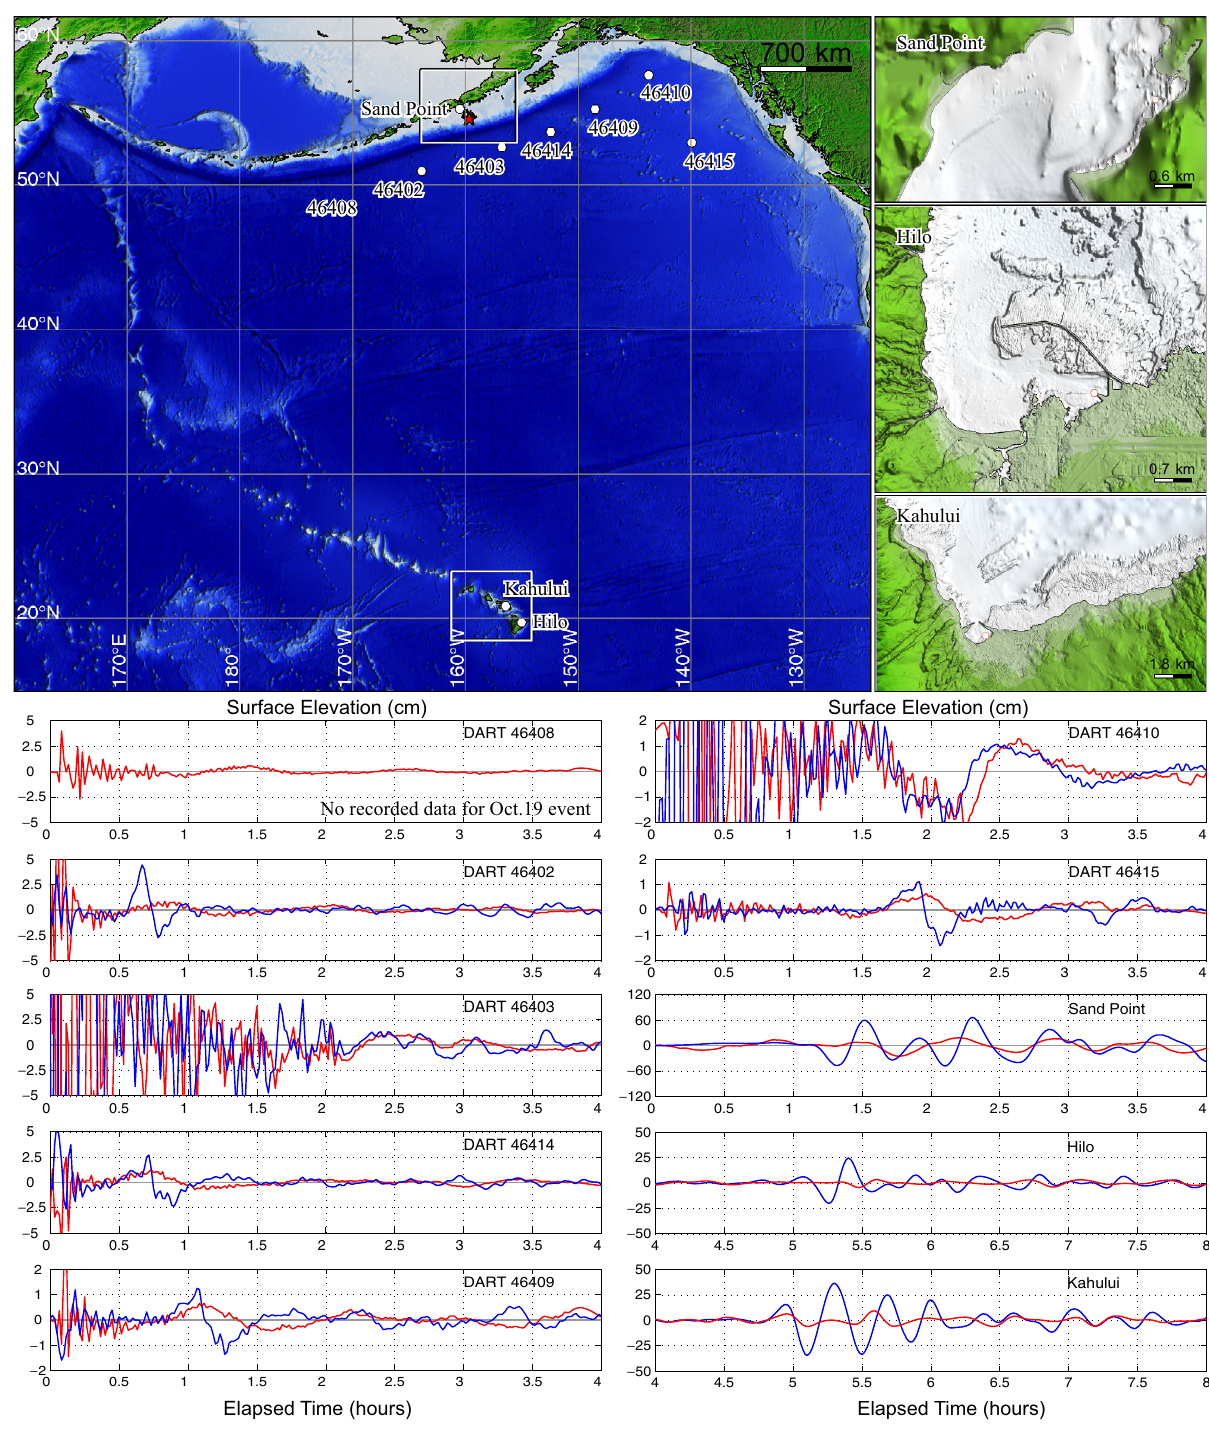
Fig.2|TsunamiobservationsfortheShumaginSegmentearthquakes. Topleft: mapofnorthPaci fi cbathymetrywithlocationoftheDARTstationsandtidegauges at Sand Point, Alaska, and Hilo and Kahului, Hawaii (labeled white circles). The red star indicates the location of the 19 October 2020 rupture. Top right: high-